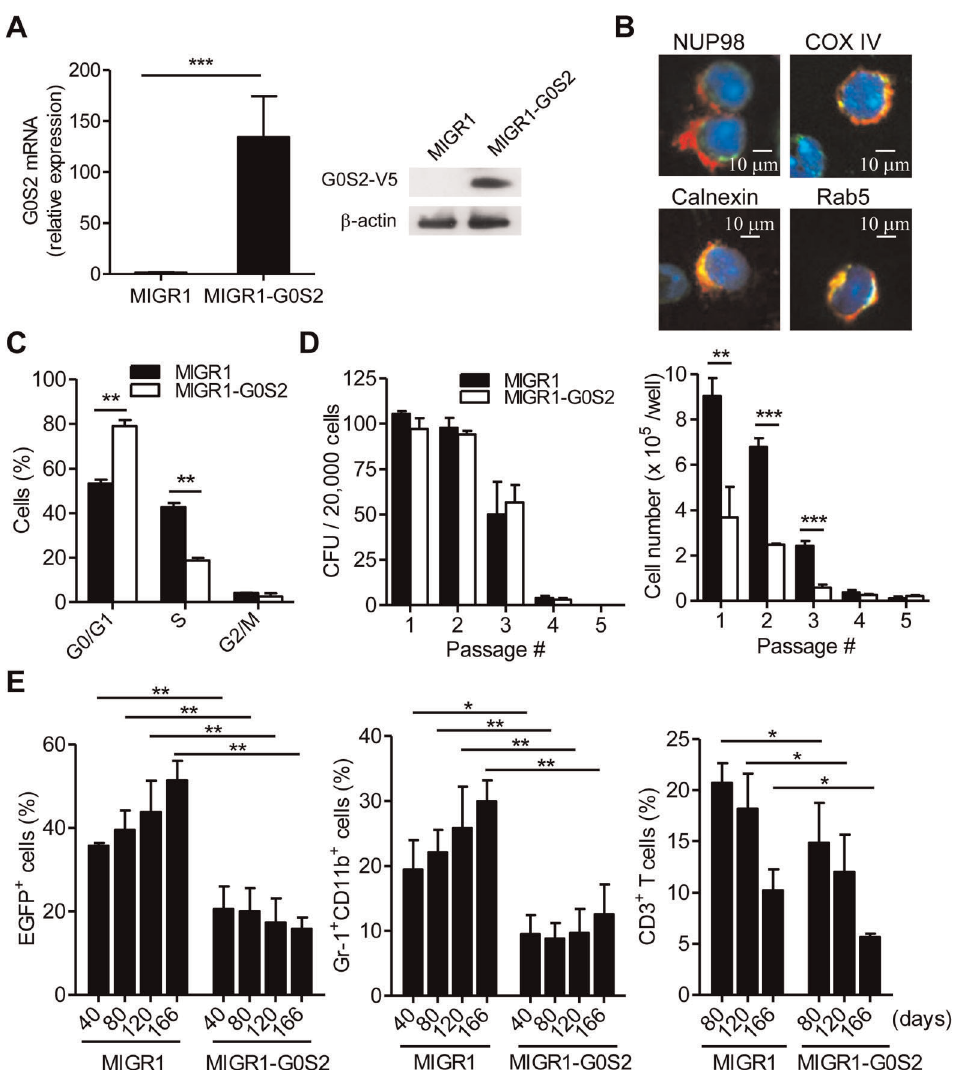
Figure 2. Ectopic G0S2 expression reduces hematological reconstitution after BM transplantation. BM cells were transduced with control MIGR1 or MIGR1-G0S2 (V5-tagged) retroviruses to study the effect of G0S2 on hematopoiesis. (A) Retroviral expression of G0S2 was measured by quantitative real-time PCR and immunoblotting ( n =3). (B) Transduced BM cells were used to study subcellular localization using anti-V5 (red), DAPI (blue) and anti-Nup98, COX IV, Calnexin or Rab5 (green) antibodies. The data represent three independent experiments. (C) The cell-cycle distribution of transduced BM cells was analyzed using nuclear staining with propidium iodine and flow cytometry ( n =3). (D) Transduced BM cells were transplanted into lethally irradiated mice and the frequency (CFU) and colony cell number were enumerated in methylcellulose culture ( n =3) after three months of hematologic reconstitution. (E) The contribution of donor-derived cells to myeloid and T cell populations in the peripheral blood was analyzed after transplantation by flow cytometry at different times post-transplant ( n =3–4). The data are representative of two independent experiments. *, P , 0.05, **, P , 0.01, and ***, P , 0.001 (two-tailed Student’s t -test).